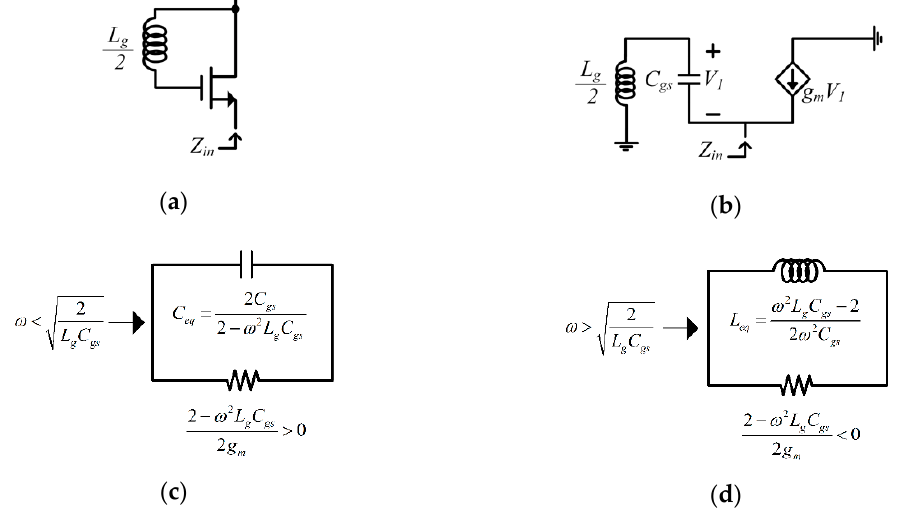
Figure 2. ( a ) The FSNR circuit; ( b ) its equivalent small-signal circuit, equivalent circuit of FSNR with; ( c ) capacitive reactance, and; ( d ) inductive reactance.